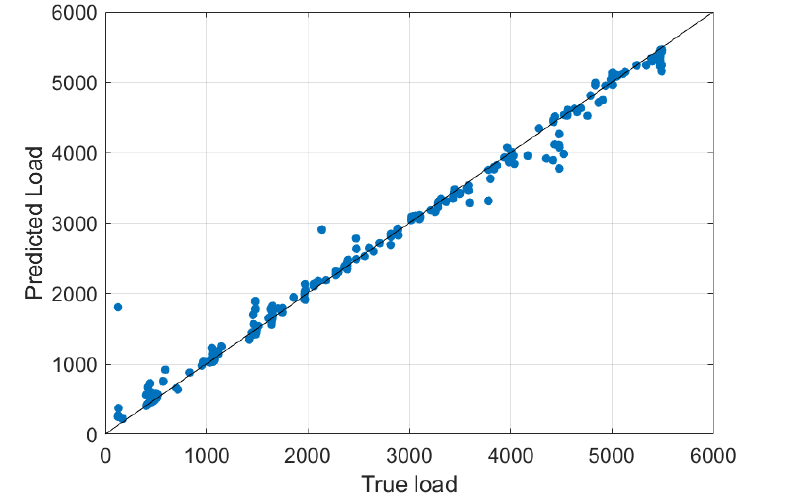
Figure 10. Correlation diagram for machine